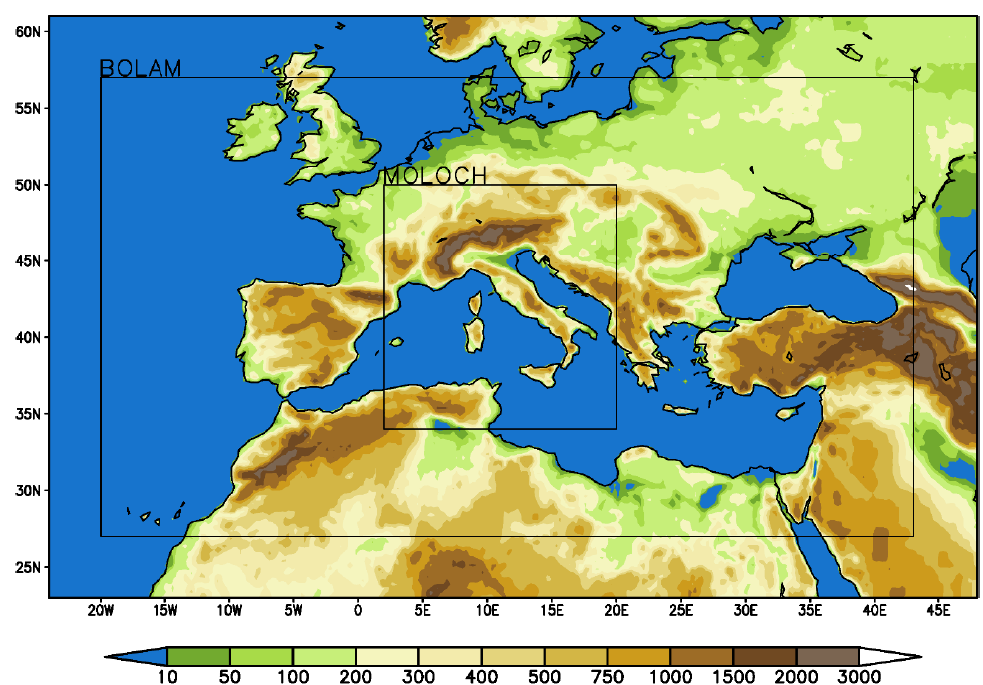
Figure 1. Extent of the BOLAM and MOLOCH domains with superimposed topography. The BOLAM domain approximately corresponds to the Med-CORDEX domain [53].